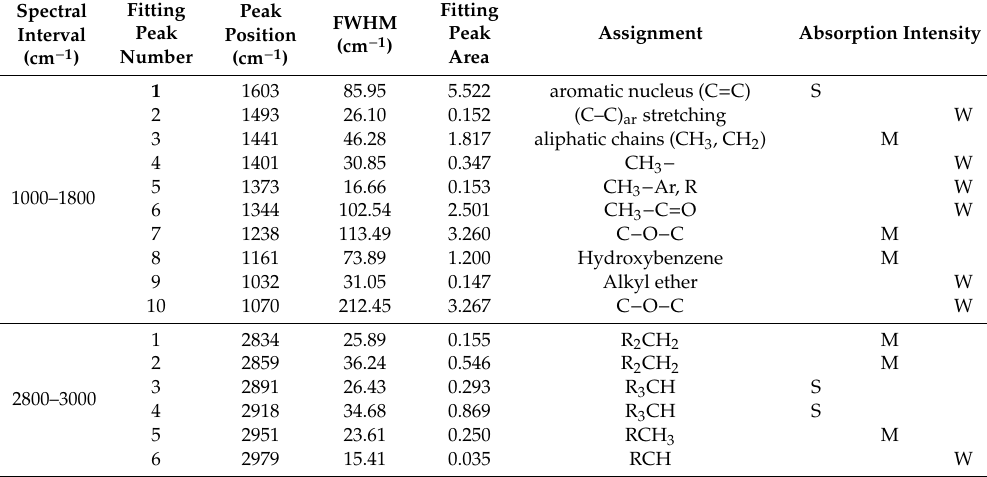
Table 2. Absorption peak parameters and assignment of the demineralized HNC in the 1000–1800 and 2800–3000 cm − 1